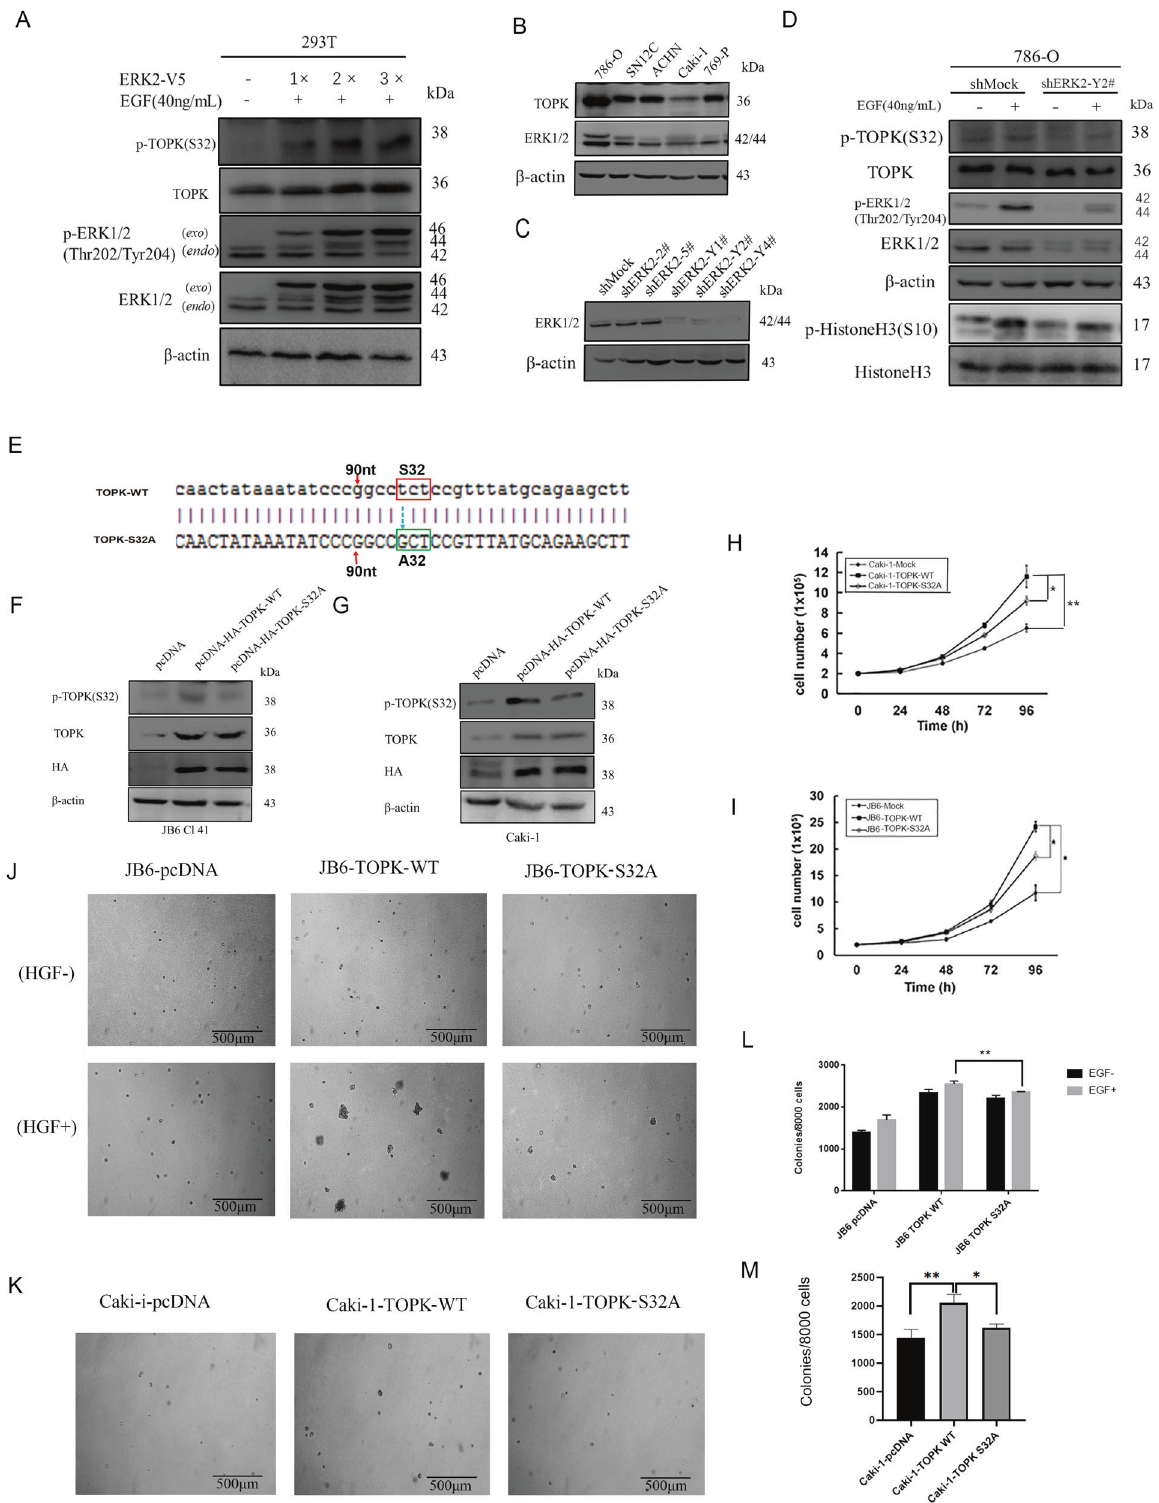
Fig. 3 ERK2 effect the phosphorylation of TOPK at S32 in vitro. The phosphorylation of TOPK at S32 promotes carcinogenesis of RCC ex vivo. A The phosphorylation of TOPK at Ser32 was detected in 293T cells which were transiently transfected with ERK2 and then activated by EGF at 40 ng/ml, 15 min. B TOPK expression level was compared in fi ve Renal cancer cell lines by westen-blot. C ERK2 was knocked down in 786- O cell line by lentivirus and the effect of fi ve shERK2 vectors was veri fi ed. D The expression of p-TOPK (S32), TOPK, ERK1/2 and p-ERK 1/2(Thr202/ Tyr204) was detected in these cell lines. E The S32 of TOPK was mutant into A32. F , G pcDNA3, pcDNA3-HA-TOPK-WT and pcDNA3-HA-TOPK- S32A was stable transfected into JB6 Cl41 and Caki-1 cell lines respectively. H , I The proliferation capability of both cells was visualized by growth curve. J – M The colony formation in soft agar was performed after the cells were stimulated with or without EGF. Data were represented as means ± SD of triplicate experiments. *, means P < 0.05, **, means P < 0.01. exo mains exogenous ERK2, endo mains endogenous ERK2. Cell Death and Disease (2022)